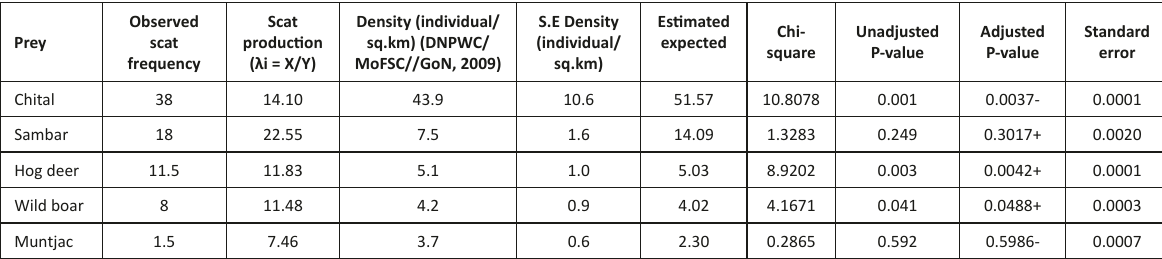
Table 2. The observed and expected frequencies of prey items in the study of food habit of tiger from scat samples in Chitwan National Park, 2010. Bootstrap replications were set at 1000 and the variability in scat production rates was set at 40% of the mean level. Sign + and - indicates preference and avoidance